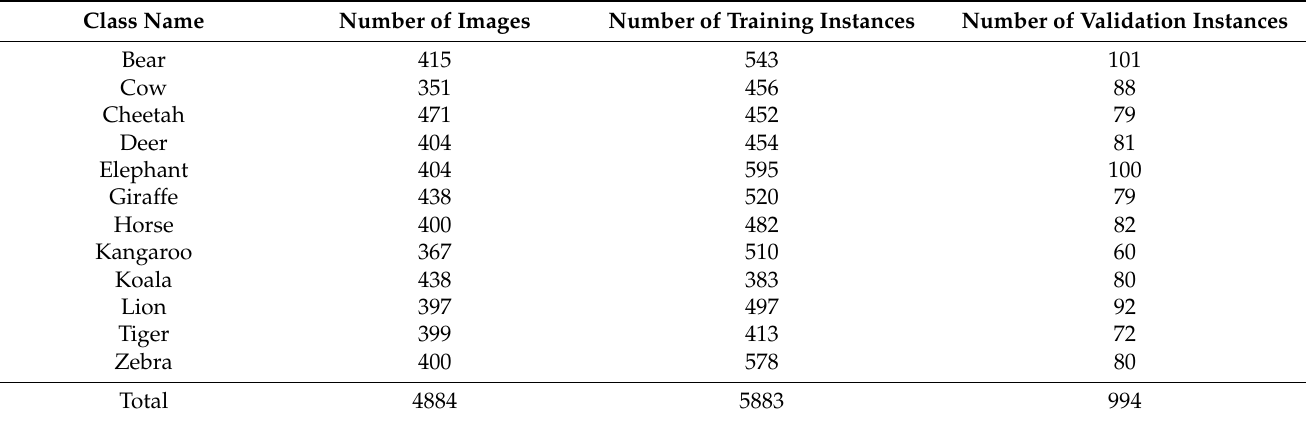
Figure 2. Examples of the dataset. The first two rows display one example of each mammal species in the dataset. The third row shows incomplete body parts, such as an elephant’s trunk, zebra stripes, cheetah leg, and so on. Table 1. Composition of the dataset MammData.